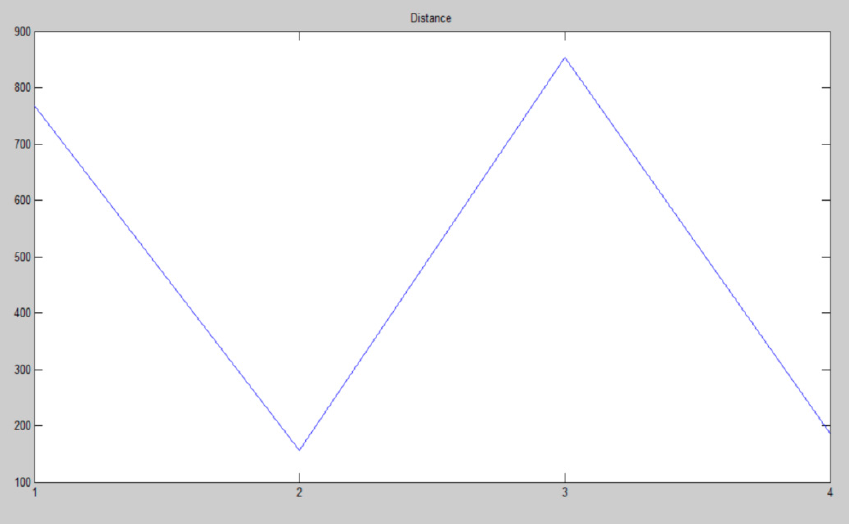
Figure 14. Distance parameters. Table 12 is the distance number for each channel. Table 12. Distance parameters.